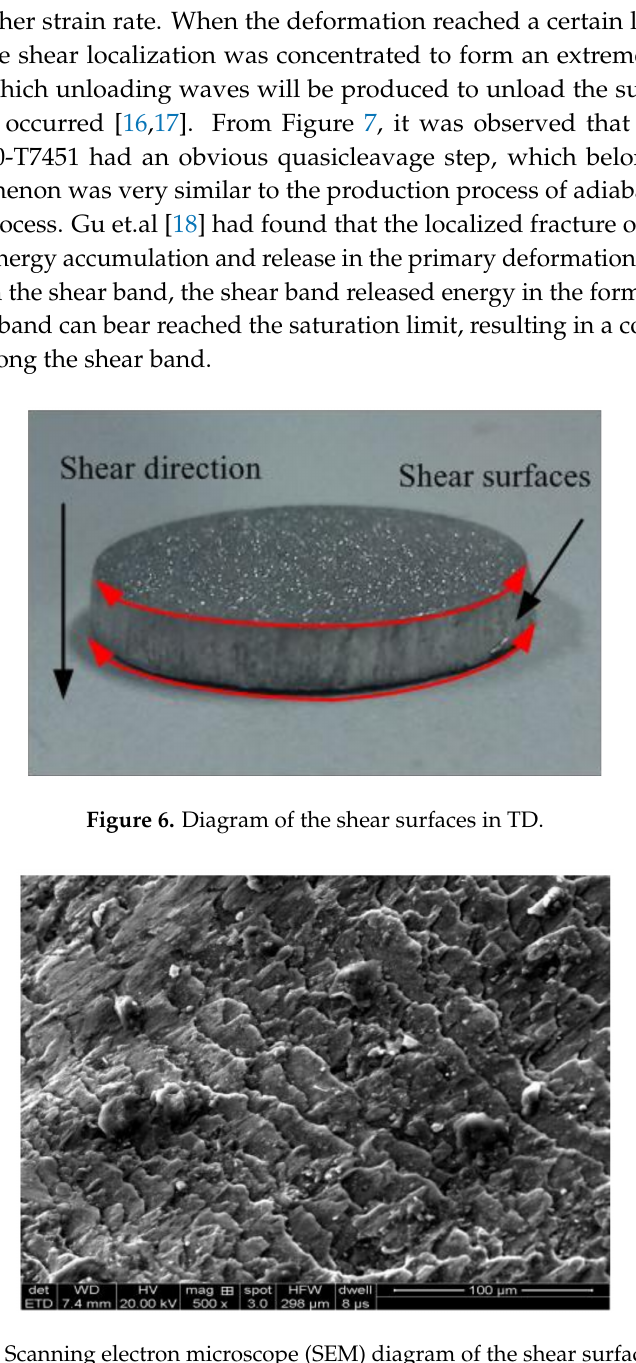
Figure 7. Scanning electron microscope (SEM) diagram of the shear surface in